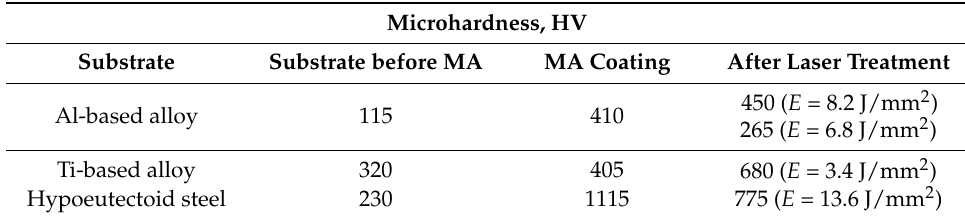
Figure 4. The resulting thickness of the obtained Ni-Ti coatings on the Ti-based alloy substrate, ( a ) after MA deposition and ( b ) after laser treatment with the total energy per unit area of about 3.4 J/mm 2 . Table 2. Microhardness of the initial substrates and coatings, obtained by the MA and a subsequent laser treatment.